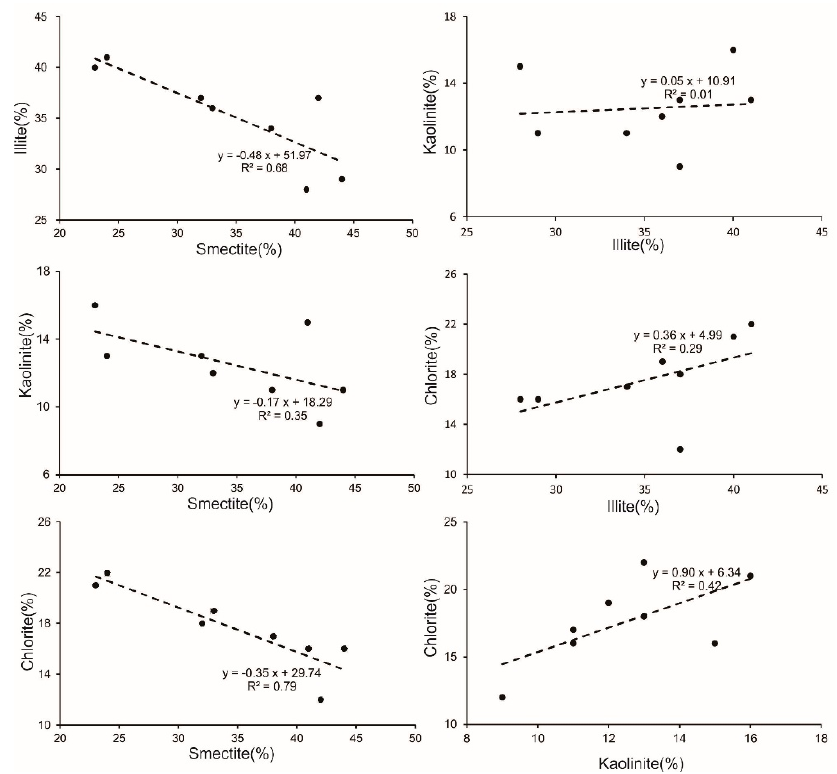
Figure 5. Variation diagrams of clay minerals of surface sediments in the Xisha Uplift.